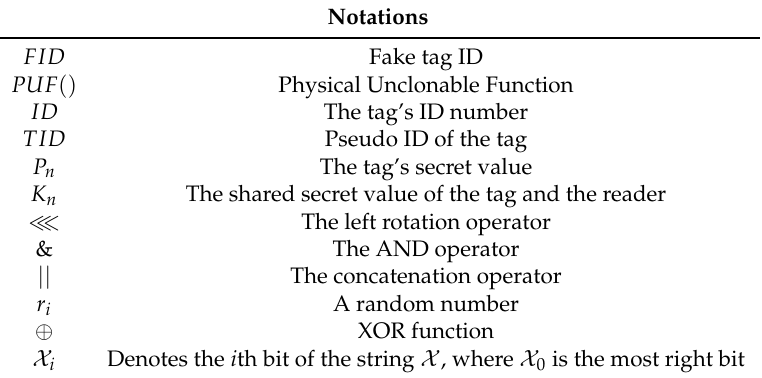
Table 1. The notations used in the Xu et al.’s